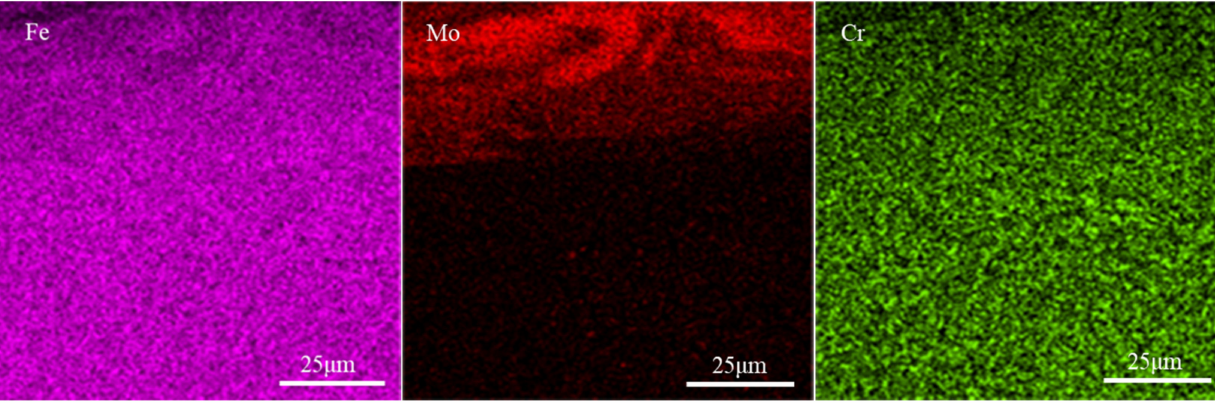
Figure 15. Map scanning results of elemental distribution of coating fabricated under 1000 W/350 Hz/(3 min/cm 2 ).